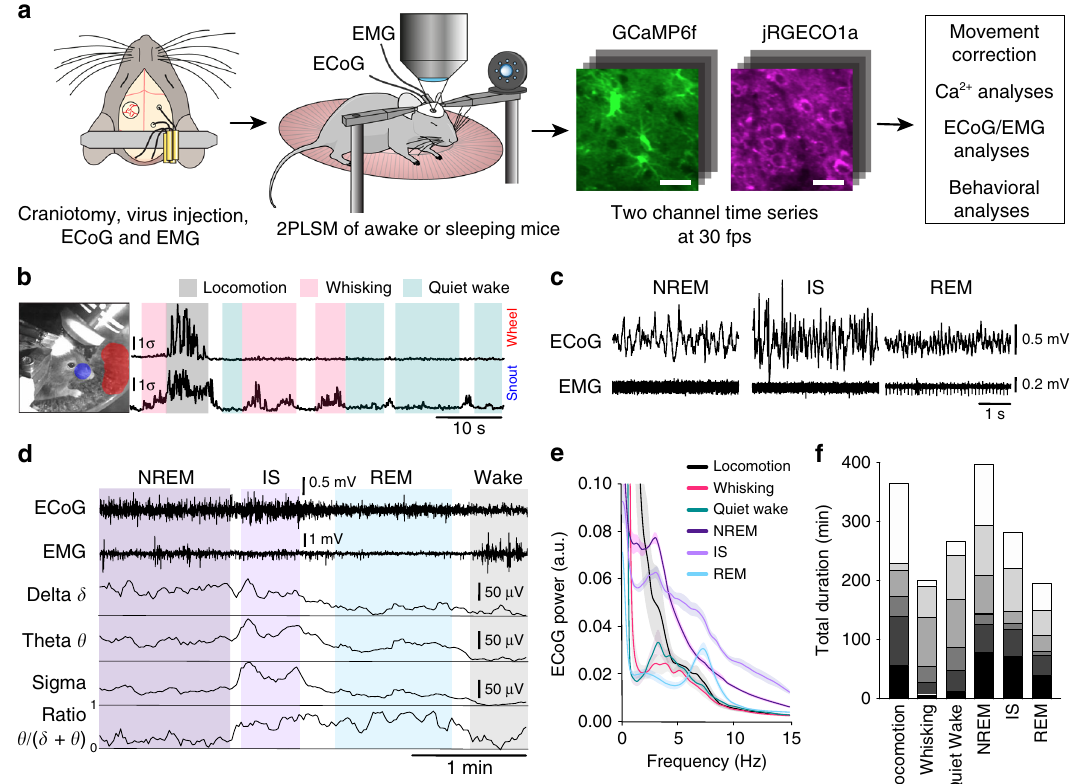
Fig. 1 Two-photon imaging of Ca 2 + signals in awake and naturally sleeping mice. a Experimental setup. A craniotomy exposing the barrel cortex was made, and a mixture of rAAV- GFAP -GCaMP6f and rAAV- SYN -jRGECO1a was injected for visualization of astrocytic and neuronal Ca 2 + signals, respectively. Scale bar 30 μ m. In all 6 mice per genotype were prepared in this fashion. ECoG and EMG electrodes were implanted, and in combination with IR surveillance video allowed classi fi cation of the sleep-wake state. b Wakefulness was separated into locomotion, whisking, and quiet wakefulness based on movement of the mouse ′ s snout and of the running wheel detected in the surveillance video. c Representative ECoG and EMG recordings of NREM, IS, and REM sleep states. d Sleep is categorized into NREM, IS, and REM sleep states based on the delta ( δ ), theta ( θ ), and sigma ( σ ) frequency band power, EMG and theta to delta frequency band ratio. e ECoG power density spectrum of sleep-wake states, normalized to the average total power in the 0.5 – 30 Hz frequency range during NREM sleep, n = 6 mice, mean ± SEM. f Total duration of each wake-sleep state from every mouse. Individual mice are indicated as separate blocks in bars, n = 6 mice. See Supplementary Figs. 1 –